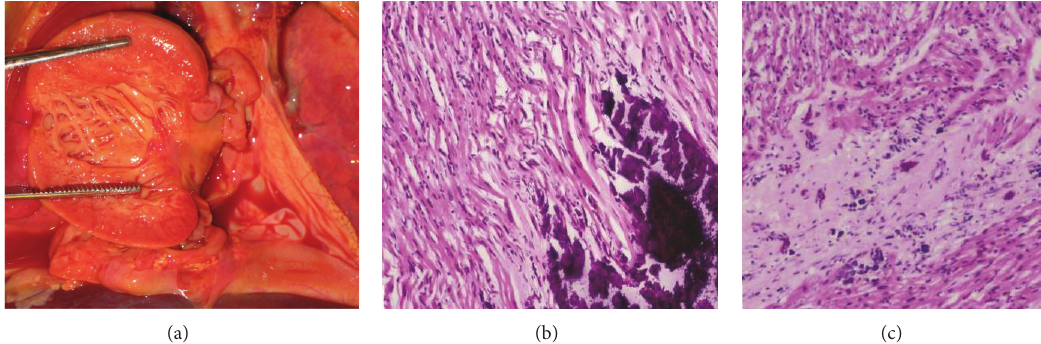
Figure 2: (a) A cut section of the heart demonstrates significant increase in cardiac wall thickness. ((b), (c)) Microscopic section of the heart shows myocardium with extensive calcium deposition (b) and fibrosis (c) with no evidence of inflammation (hematoxylin-eosin, original magnification × 200 [( b ), ( c )] ).